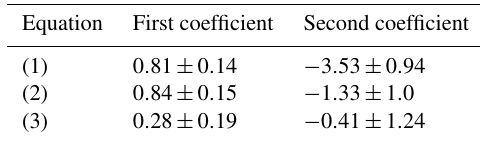
Table 3. Coefficients of the regressions (1–3) and their standard